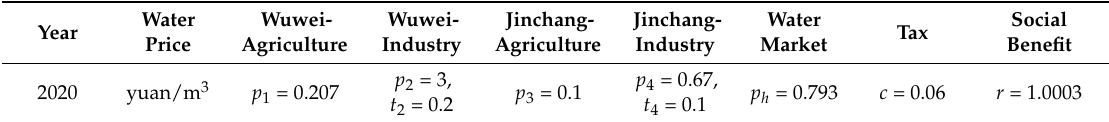
Table 10. Optimized water price for planning year 2020.